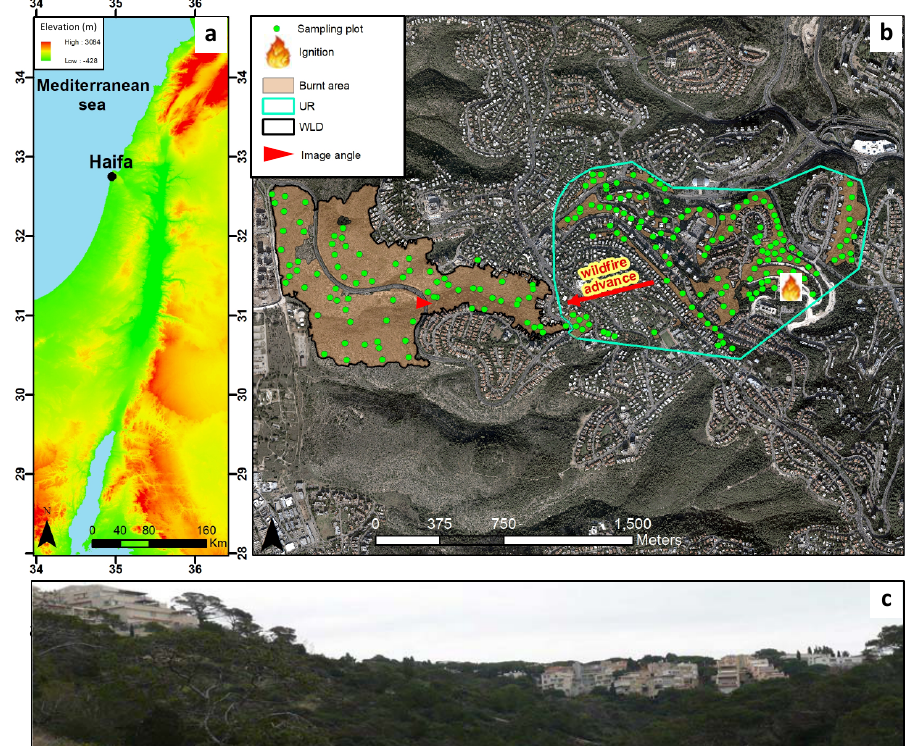
Figure 1. ( a ) Location of the study area: the city of Haifa, Northern Israel. ( b ) The WUI of Haifa divided into urban (UR) and wildland (WLD) domains. Post-fire sampling plots are indicated as green dots in ( b ). The location where the fire was ignited and fire advance direction are shown. ( c ) Panoramic view of the WLD as seen from west of the city (location from where the photo was taken and view angle are indicated in ( b ). Photo credit: Odit Abu-Thief and Alexander Eyal.